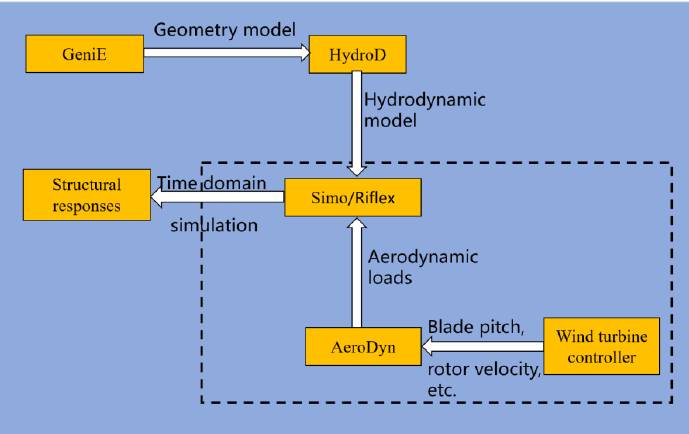
Figure 8. Coupling analysis in SESAM and SIMA.